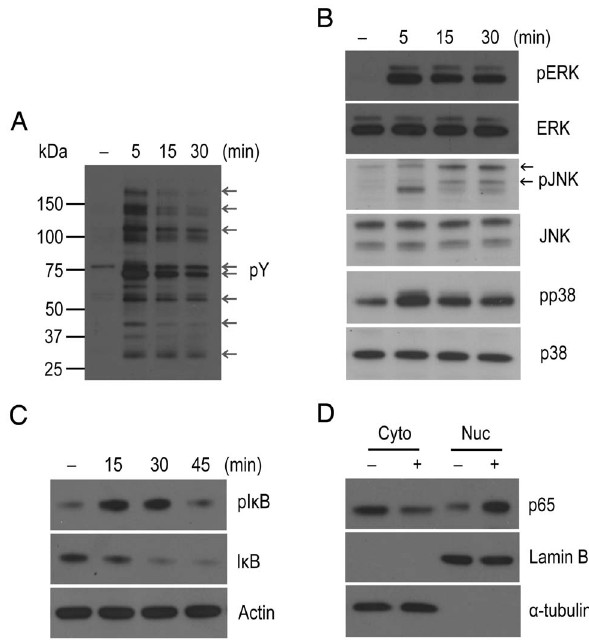
Figure 2. OmpA stimulates phosphorylation of protein tyrosine kinases, ERK, JNK and p38 and induces NF- k B activation. B cells were incubated with 5 m g/ml of OmpA for the indicated times, and cell lysates were probed for phosphotyrosine (pY) ( A ), and phosphorylated and total ERK, JNK and p38 ( B ). Representative blots from three independent experiments are shown. Arrows in the pY blot show bands with higher tyrosine phosphorylation. ( C ) B cells were purified from the spleen of BALB’/c mice, stimulated with OmpA (5 m g/ml) for the indicated times, and lysates were probed with phosphorylated and total I k B a . b -Actin was used as an internal control. The data is representative of three independent experiments. ( D ) B cells were cultured in absence and presence of OmpA for 30 min. The cytoplasmic (Cyto) and nuclear (Nuc) extracts were analyzed for p65, Lamin B1 (nuclear marker) and a - tubulin (Cytoplasmic marker) by Western blot analysis. The data shown are representative of three independent experiments.